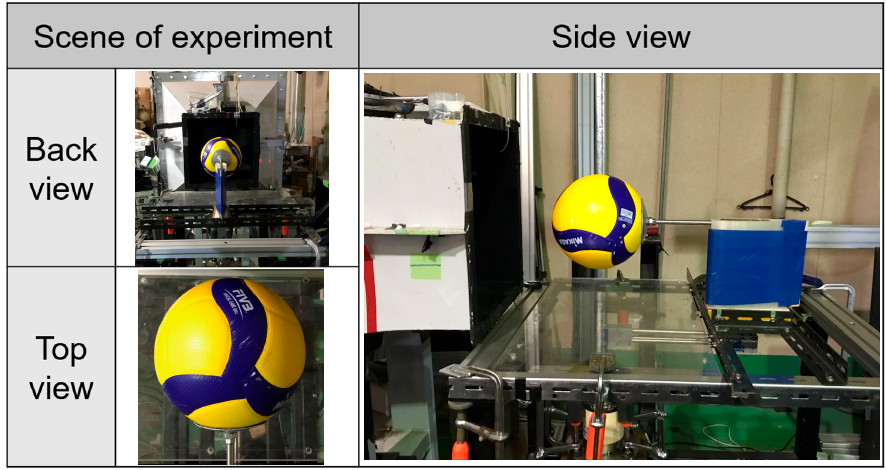
Figure 2. Appearance of cobra-type ball support.